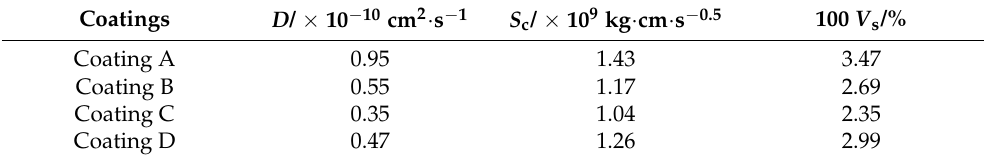
Figure 4. A DSC thermogram of Coating C before and after immersion tests. Table 2. Calculated and fitted water uptake results for the coatings aged in 5 wt.% NaCl solution. Coatings